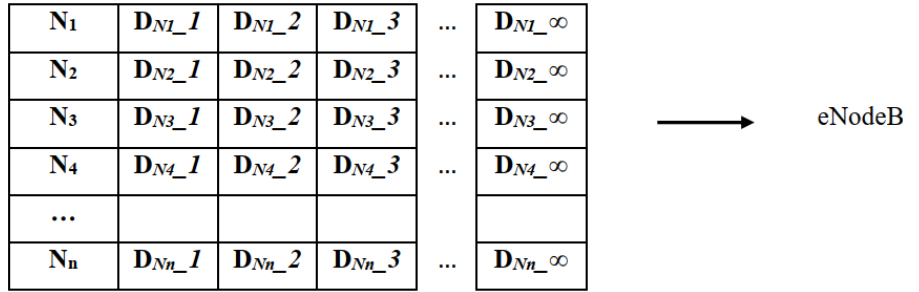
Figure 3. System model: Queues of devices in